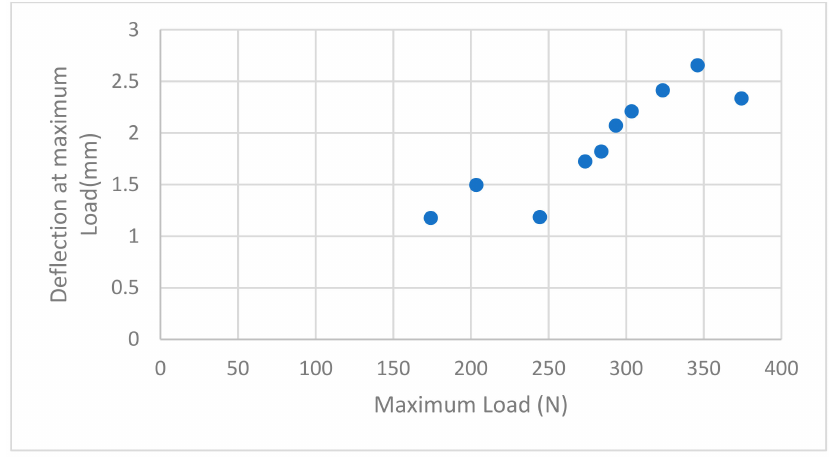
Figure 7. Maximum deflection with maximum load applied to IPS e-max Press crowns with RPD framework. Table 3. The mean fracture strength of zirconia crowns from the previous research [34] was signifi- cantly higher than that of RPD saddles with zirconia crowns in this study ( p ≤ 0.05). Sample No Zirconia RPD with Zirconia 1 3020 N 335 N 2 2949 N 305 N 3 3405 N 386 N 4 3353 N 313 N 5 3275 N 400 N 6 3277 N 367 N 7 2248 N 376 N 8 2402 N 206 N 9 2427 N 312 N 10 3184 N 304 N mean 2954 N 320 N Standard deviation ± 320 N ± 21